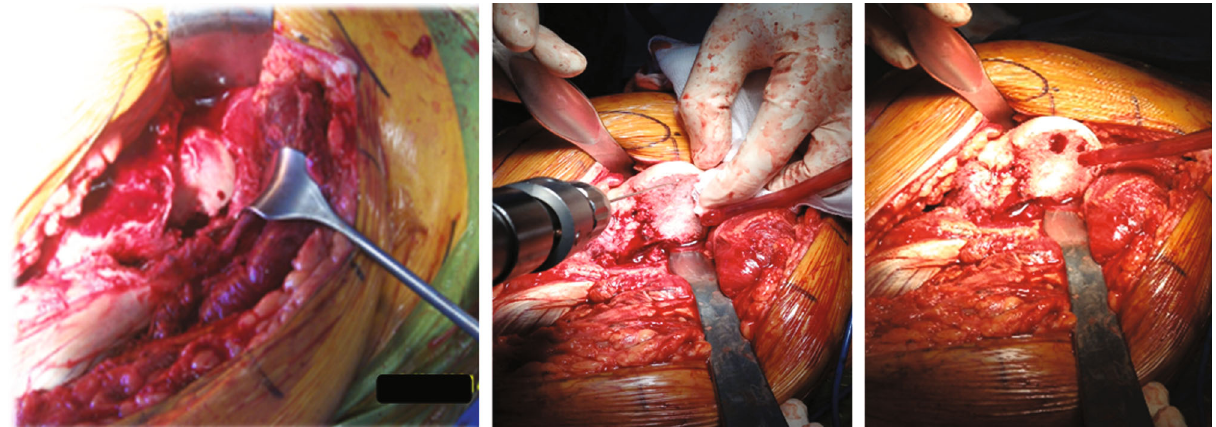
Figure 2: Intraoperative exposure of the femoral head through a surgical hip dislocation approach and intraoperative assessment of femoral head vascularization performed with K-wire perforation.